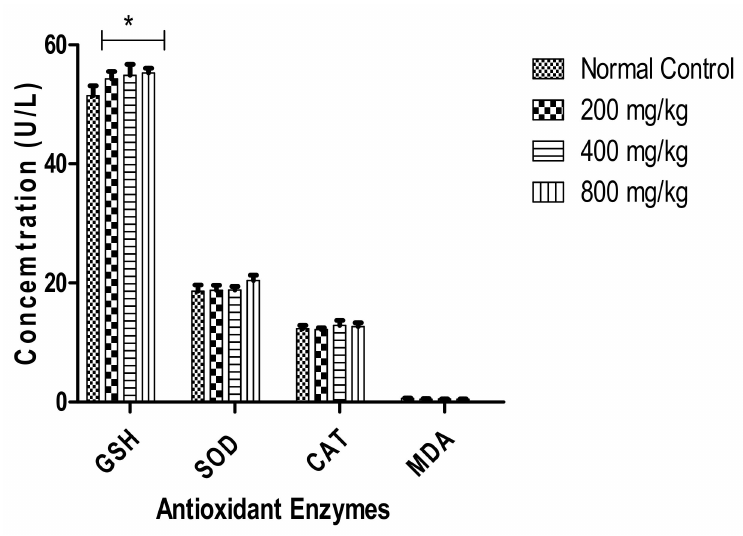
Figure 6. Effect of aqueous extract of C. pepo on antioxidant enzyme on male rats. Values represent the mean ± SD for n = 6. * indicates significance at ( p < 0.05). Group of bars without asterisks are not significant at p < 0.05. GSH, Glutathione; SOD, Superoxide Dismutase; CAT, Catalase; and MDA, Malondialdehyde.